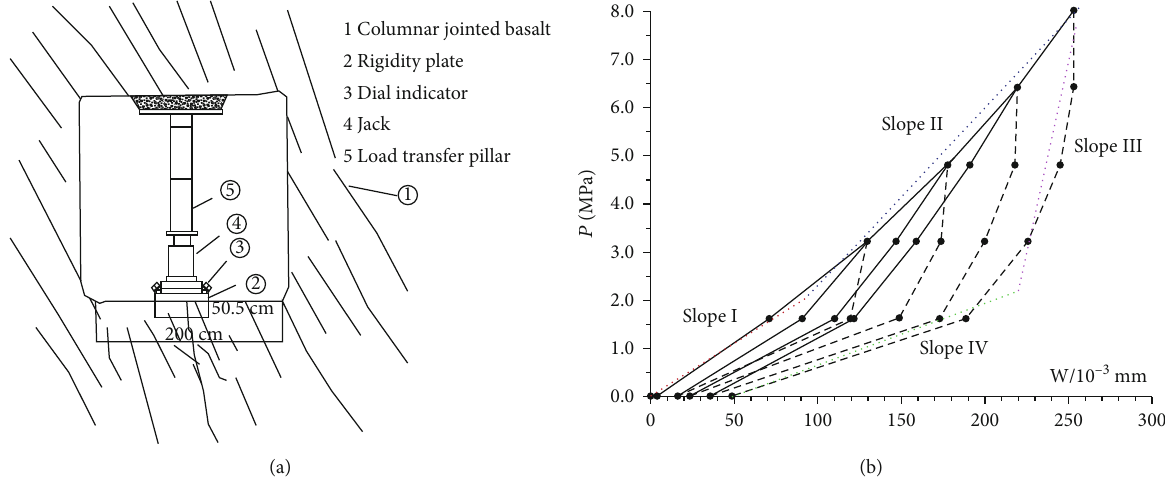
Figure 6: Deformation of columnar jointed basalt: (a) illustration of equipment system and (b) typical loading-unloading curve of columnar jointed rock.